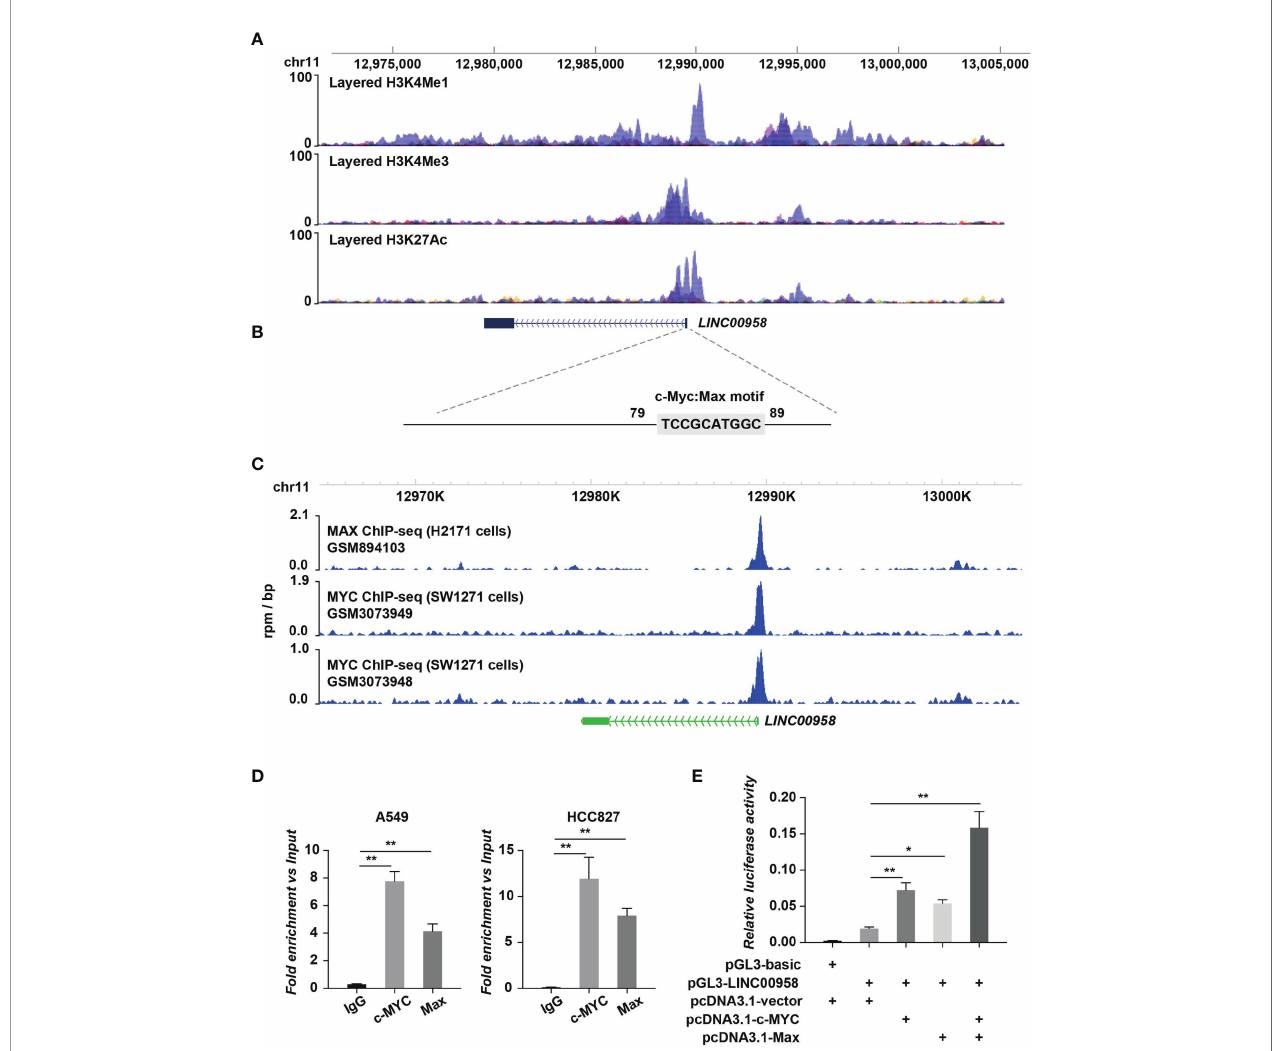
FIGURE 8 | MYC/MAX upregulated LINC00958 expression. (A) Transcriptional regulatory regions of LINC00958. The diagram indicated the binding signals of the layered H3K27ac, H3K4me1, and H3K4me3 in the internal transcriptional unit or the proximal region of LINC00958. The layered histone markers were obtained from the ENCODE Regulation database. (B) Motif analysis revealed an MYC/MAX motif at the regulatory region of LINC00958. The sequences of regions with high H3K4me1, H3K4me3, and H3K27ac signal intensities were extracted for motif analysis. (C) MYC/MAX was bound to the promoter regions of LINC00958. Chromatin immunoprecipitation (ChIP) sequencing data that identi fi ed MYC and MAX at the regulatory regions of LINC00958 in lung cancer cells, such as H2171 and SW1271 cells, were retrieved from the Gene Expression Omnibus database (GSM894103, GSM3073948, and GSM3073949) and plotted. (D) ChIP-quantitative polymerase chain reaction analysis (ChIP-qPCR) revealed that MYC/MAX was bound to the promoter region of LINC00958 in A549 and HCC827 cells. A549 and HCC827 cells were subjected to ChIP-qPCR using anti-MYC and anti-MAX antibodies. IgG was used as the negative control. Relative enrichment versus 2% input was plotted. (E) MYC and MAX trans-activated the promoter activity of LINC00958. Relative fi re fl y luciferase activity versus Renilla luciferase activity was plotted in columns. * P < 0.01, ** P <